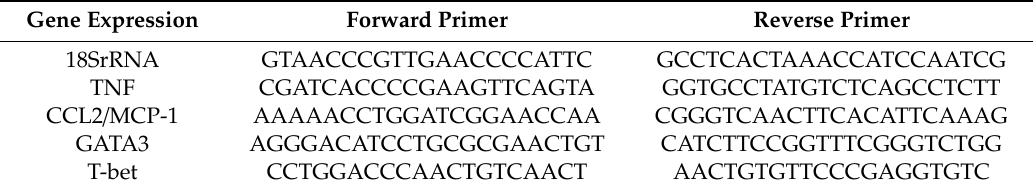
Table 2. Primer sequences for analysis of mRNA expression.